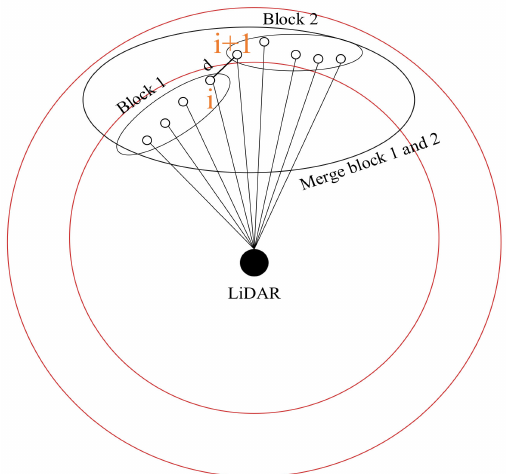
Figure 5. Merge laser-point cloud blocks. Calculate using points i and i +1, d is the distance between the two points. Blocks 1 and 2 satisfy both the angle threshold and distance